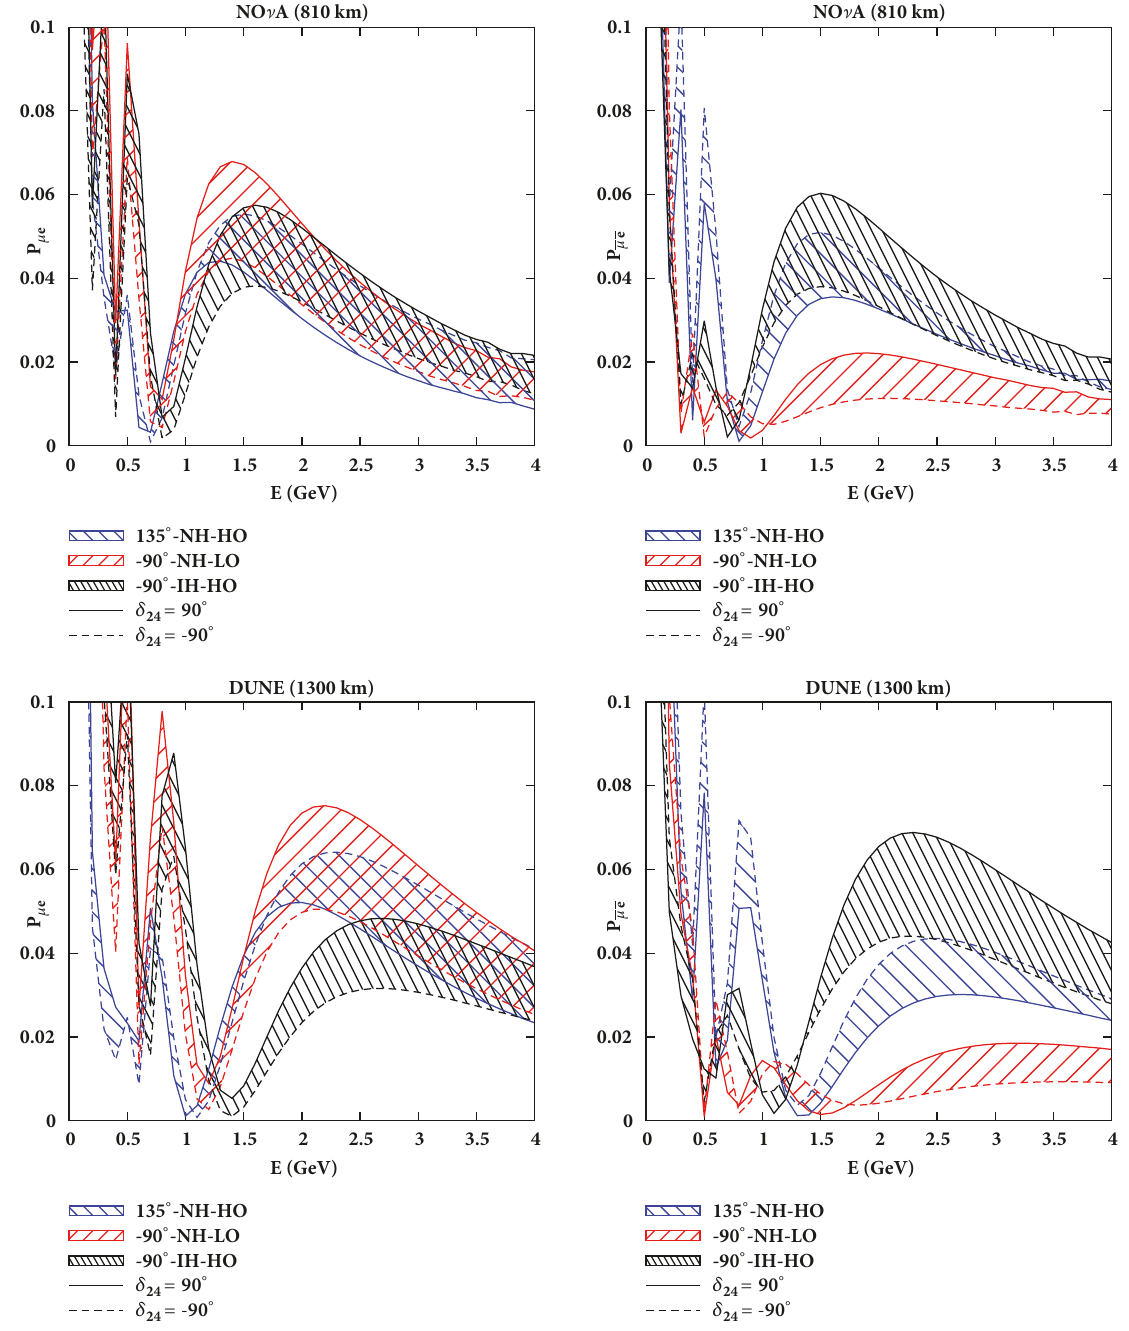
Figure 2: The oscillation probability P 𝜇𝑒 as a function of energy. The top (bottom) panel is NO ] A (DUNE). The bands correspond to different valuesof 𝛿 24 ,rangingfrom-180 ∘ to180 ∘ when 𝛿 14 = 0 ∘ .Insideeachband,theprobabilityfor 𝛿 24 =90 ∘ ( 𝛿 24 =-90 ∘ )caseisshownassolid(dashed) line. The left (right) panel is for neutrinos